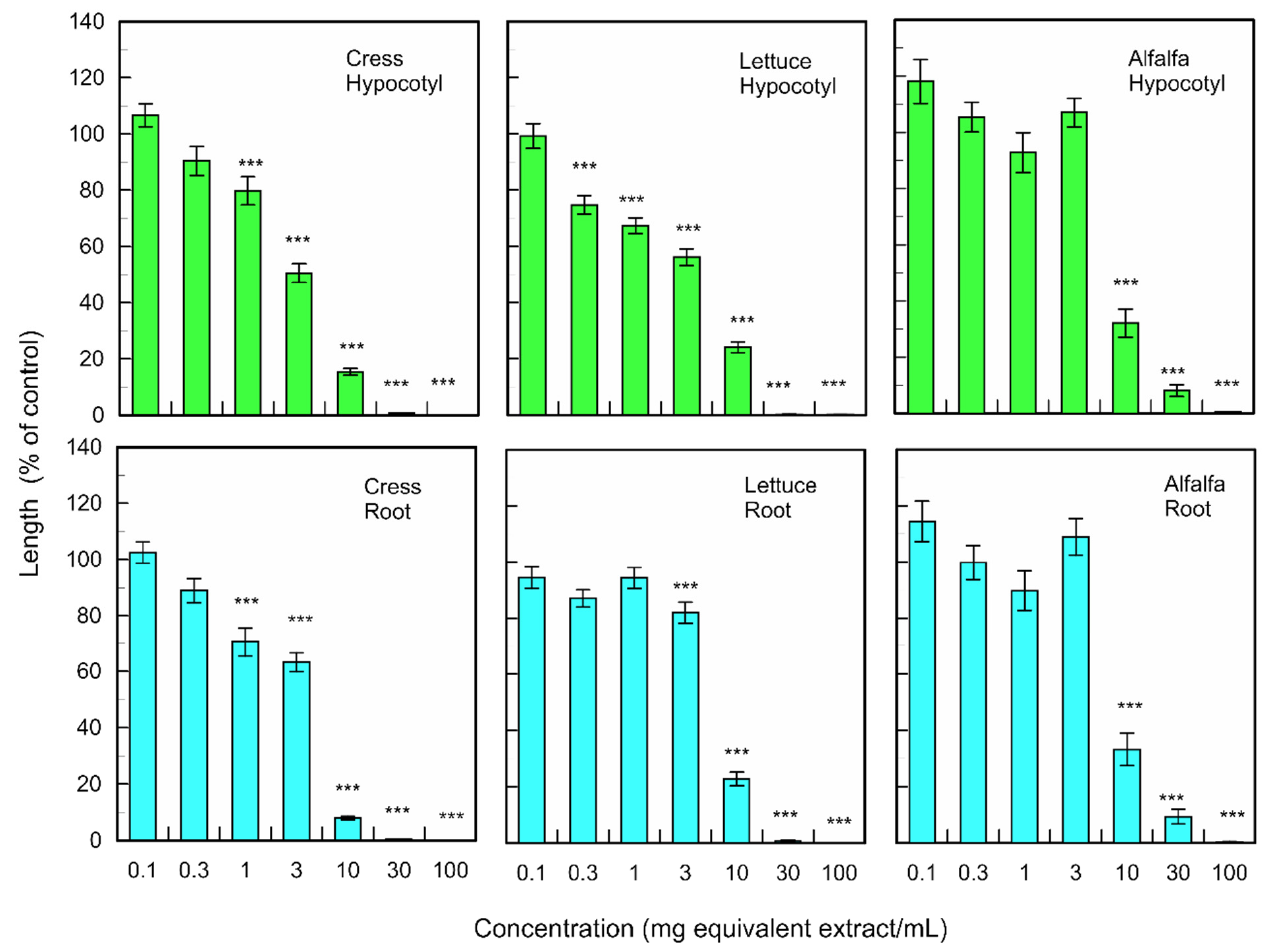
Figure 2. Effects of the extracts of M. glyptostroboides leaves on the growth of roots and hypocotyls of cress, lettuce, and alfalfa. Concentrations of tested samples corresponded to the extracts obtained from 0.1, 1, 3, 10, 30, 100, and 300 mg dry weight equivalent extract per mL. Means ±SE from three independent experiments with 10 plants for each determination are shown. Asterisks indicate significant differences between control and treatment: ***, p < 0.001.